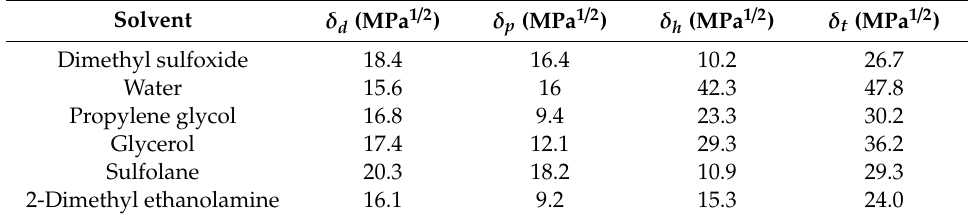
Table 1. Hansen Solubility Parameters (HSP) of solvents obtained from [29].